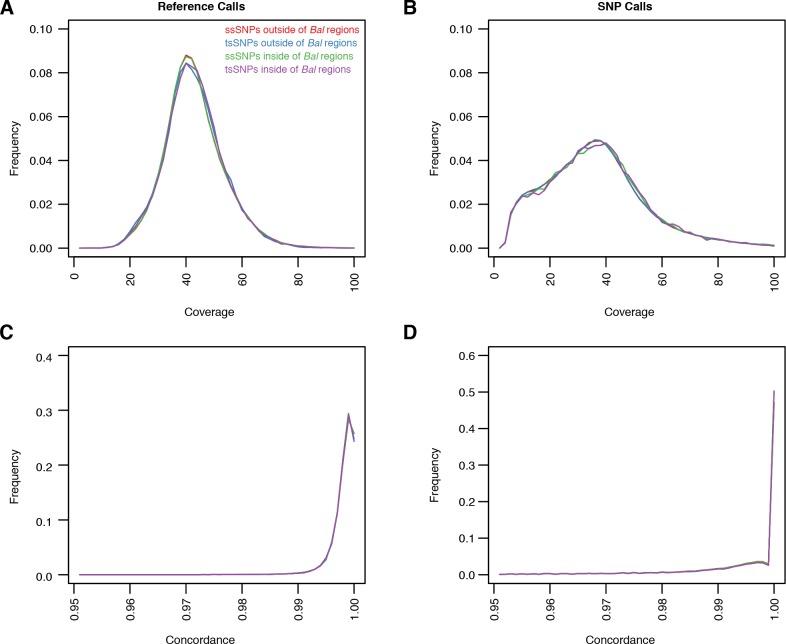
Quality metrics for ssSNPs and tsSNPs in C. rubella.(A–D) Average coverage and concordance for reference calls (A and C) or non-reference calls (B and D). ssSNPs or tsSNPs outside of regions with significant evidence for balancing selection (red and blue) or inside of these regions (green and purple). Concordance describes the fraction of reads covering a position that supports a particular allele. For example a heterozygous site might have A in 50% of the reads and T in 50% of the reads. The concordance at this site would be 0.5. We show this statistic because our SNP calling method favors homozygous calls in the selfing lineages. If we are missing some heterozygous sites, this would be revealed in the concordance values.